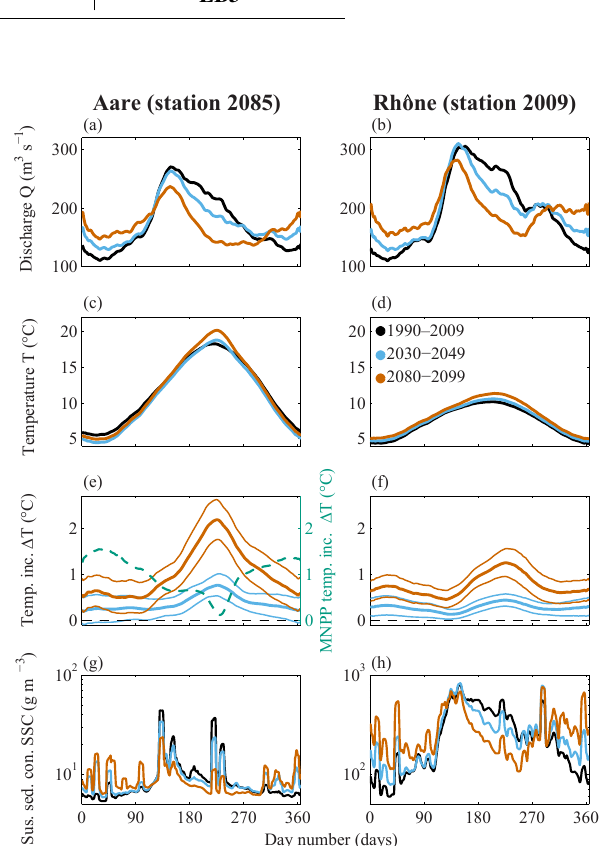
Figure 5. Modeled climate impact from scenarios LB3 (Aare River; a , c , e , g ) and LG3 (Rhône River; b , d , f , h ) displayed as daily average for reference (black, 1990–2009), near-future (blue, 2030– 2049) and far-future (orange, 2080–2099) time periods. Discharge Q ( a and b ), net water temperature T ( c and d ) with anthro- pogenic heat from Mühleberg Nuclear Power Plant (MNPP) re- moved from near-future and far-future time periods, temperature increase (cid:49)T ( e and f ) due to climate change (orange/blue), MNPP (blue-green) and modeled SSC ( g and h ). Maximum and minimum modeled values are marked by fine lines ( e and f ) and/or are omitted ( c , d , g , and h ) for